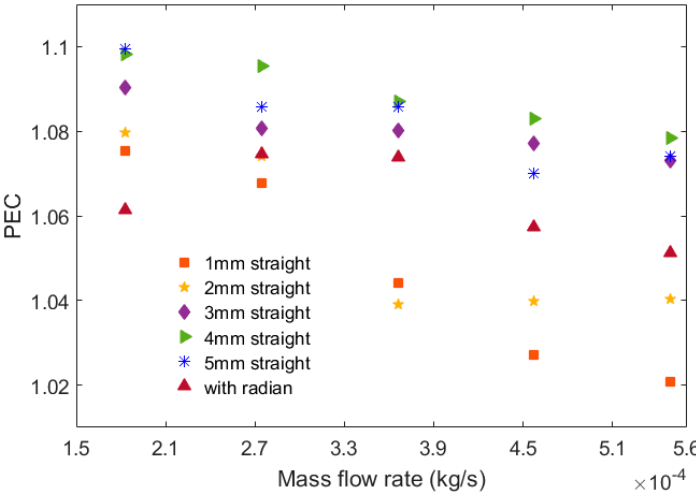
Figure 14. Fanning friction factor for different channel shapes at different mass flow rates. Energies 2019 , 12 , x FOR PEER REVIEW